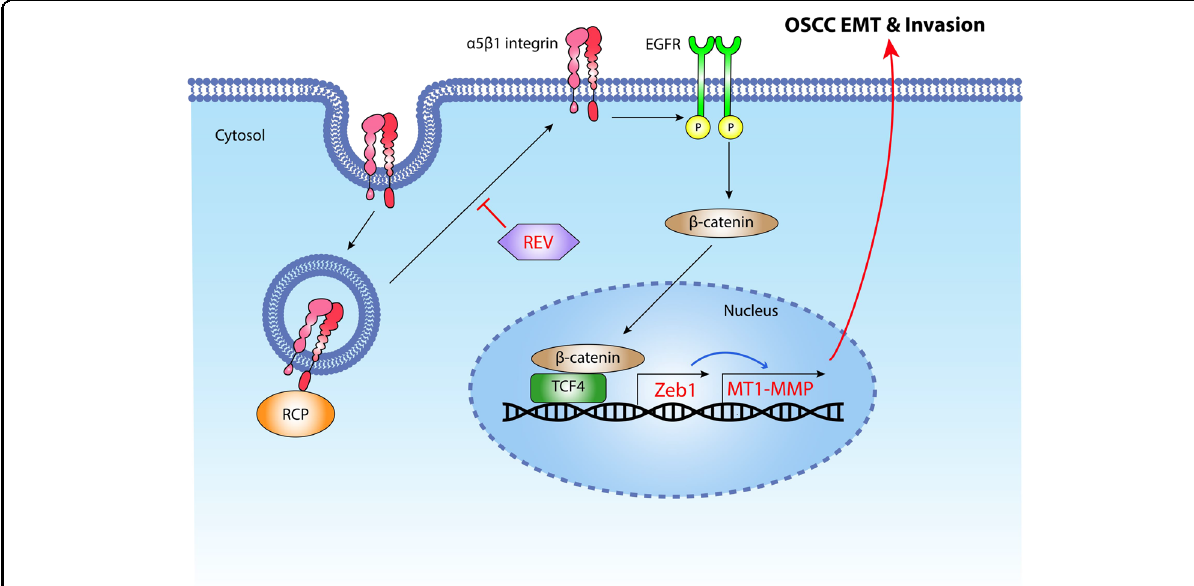
Fig. 7 Working model showing how RCP promotes OSCC invasion, which is reversed by REV. RCP induces Zeb1 and MT1-MMP expression through the β 1 integrin/EGFR/ β -catenin signaling axis to promote OSCC invasion. REV ef fi ciently blocks RCP-induced β 1 integrin relocation to the plasma membrane and EGFR activation, resulting in suppression of RCP-induced OSCC